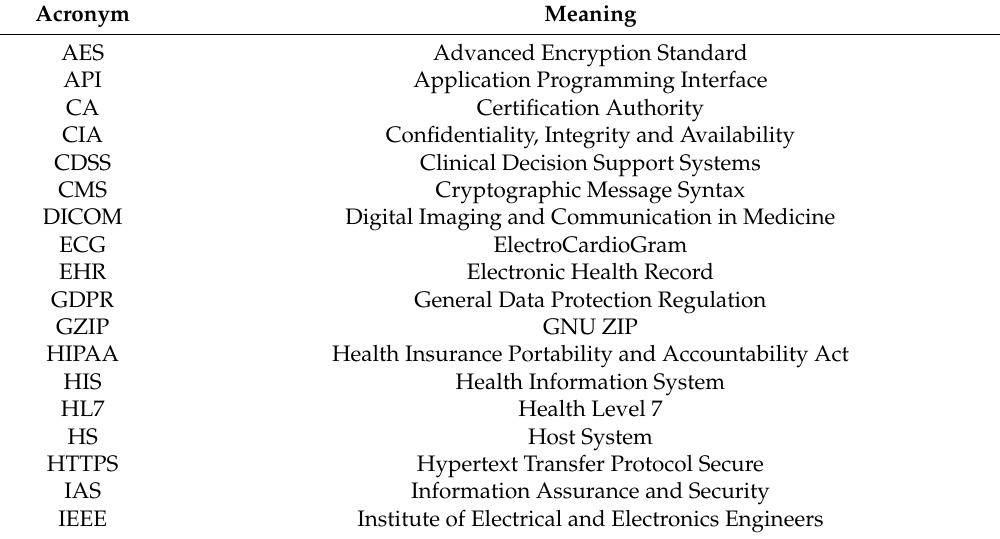
Table 1. Acronyms and their